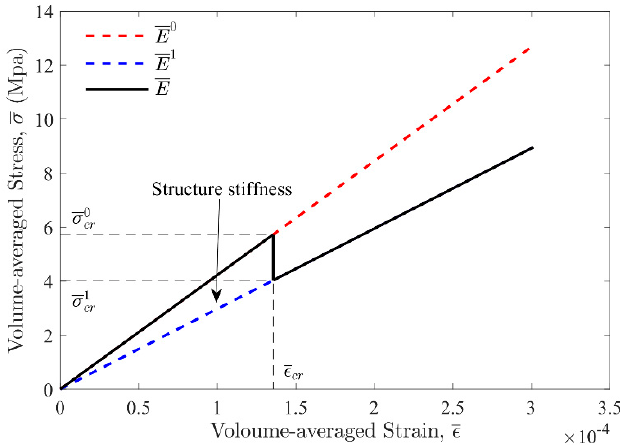
Figure 5. The volume-averaged stress–strain curve for the unit cell during “phase changing”, which is marked with the black line. The effective elastic moduli at “phase 0” and “phase 1” are marked with the red dashed line and blue dashed line, respectively. The critical average strain, ε cr , and the critical average stress, σ 0 cr , as well as σ 1 cr , is marked with black dashed line. The structure stiffness of the unit cell defined in this paper is encircled by the black line and the blue dashed line.